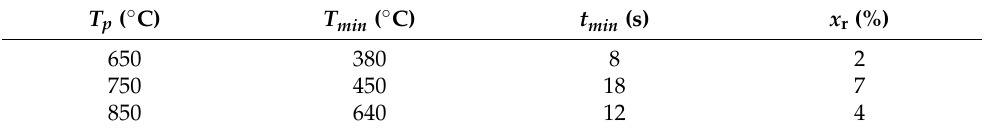
Table 4. Characteristics of the GG during pyrolysis of granular PE in an open GG at m 0 = 15